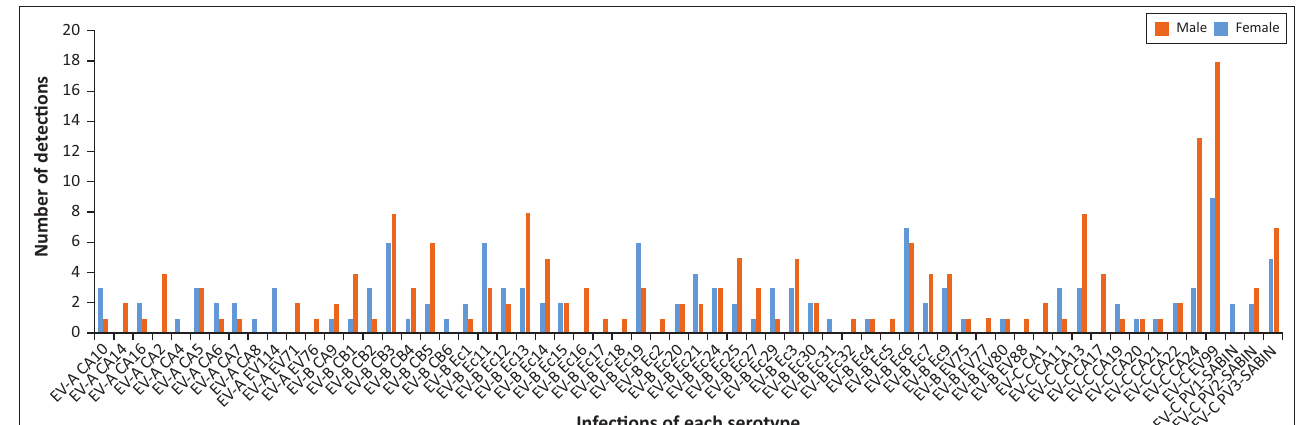
Infec(cid:26)ons of each serotype